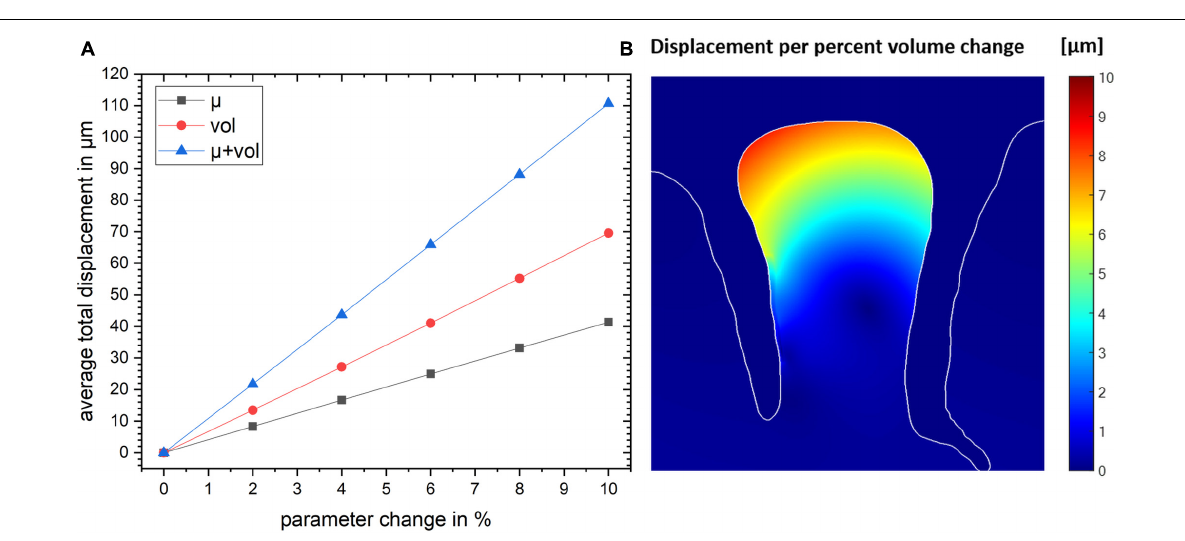
to 23.90 µ m for a change in stiffness of 2% and from 23.00 to 117.50 µ m for a stiffness change of 10%.